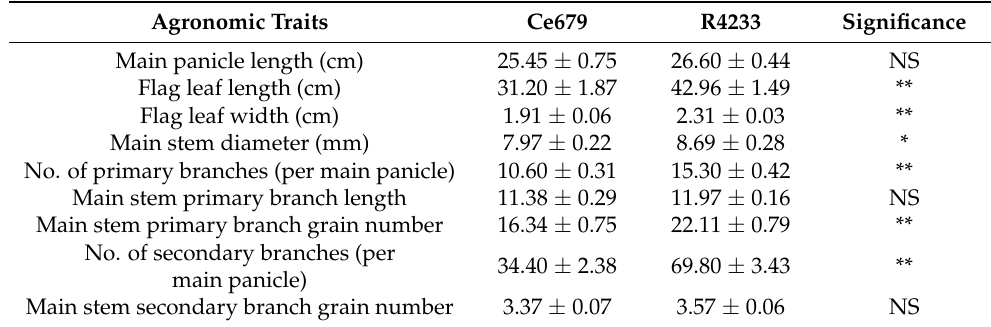
Table 1. Comparative analysis of some important agronomic traits between Ce679 and